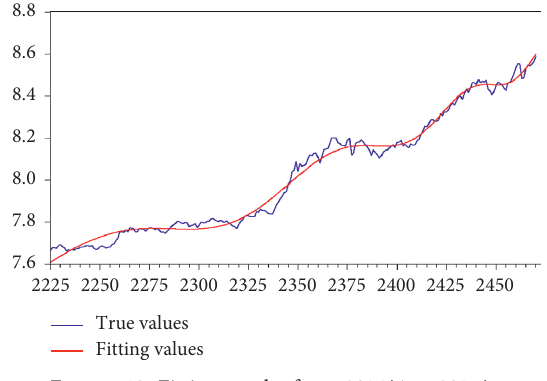
Figure 18: Fitting results from 2014/6 to 2015/5.